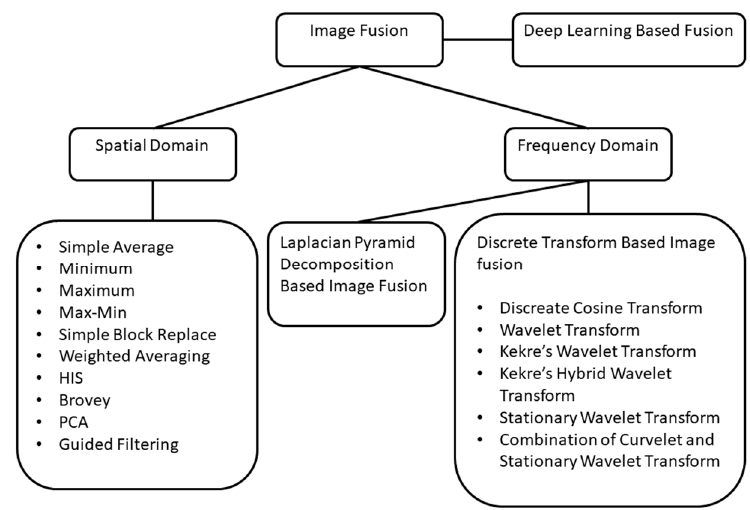
Figure 5. Image fusion techniques. Image fusion approaches with spatial and frequency domains indicate a variety of techniques and algorithms. Adapted with permission from reference [35], 2021, Springer Nature.